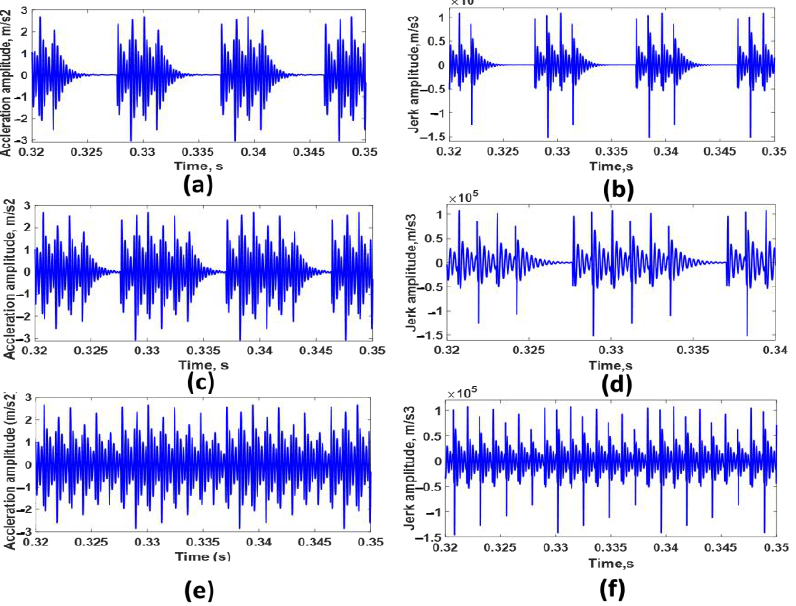
Figure 13. Dynamic response (acceleration and jerk) of a bearing has multiple bumps and dents on its outer race with 5° angle between every two defects: ( a , b ) 4 defects, ( c , d ) 6 defects, and ( e , f ) 8 defects.